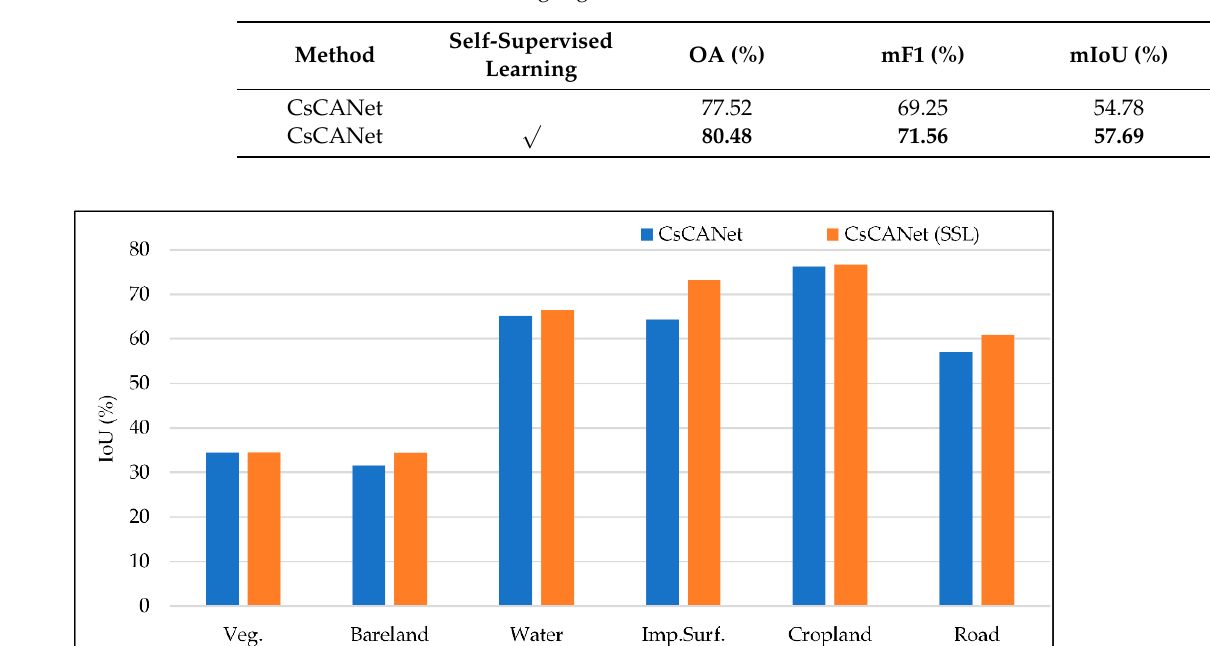
Figure 10. Per-class intersection-over-union (IoU) for land cover mapping. For all the categories, each method corresponds to a histogram with a particular color.